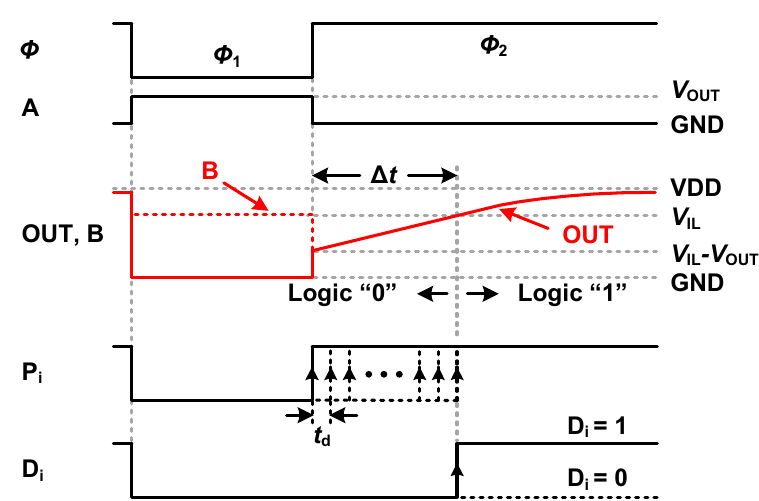
Figure 7. The timing diagram of the TDC-based signal